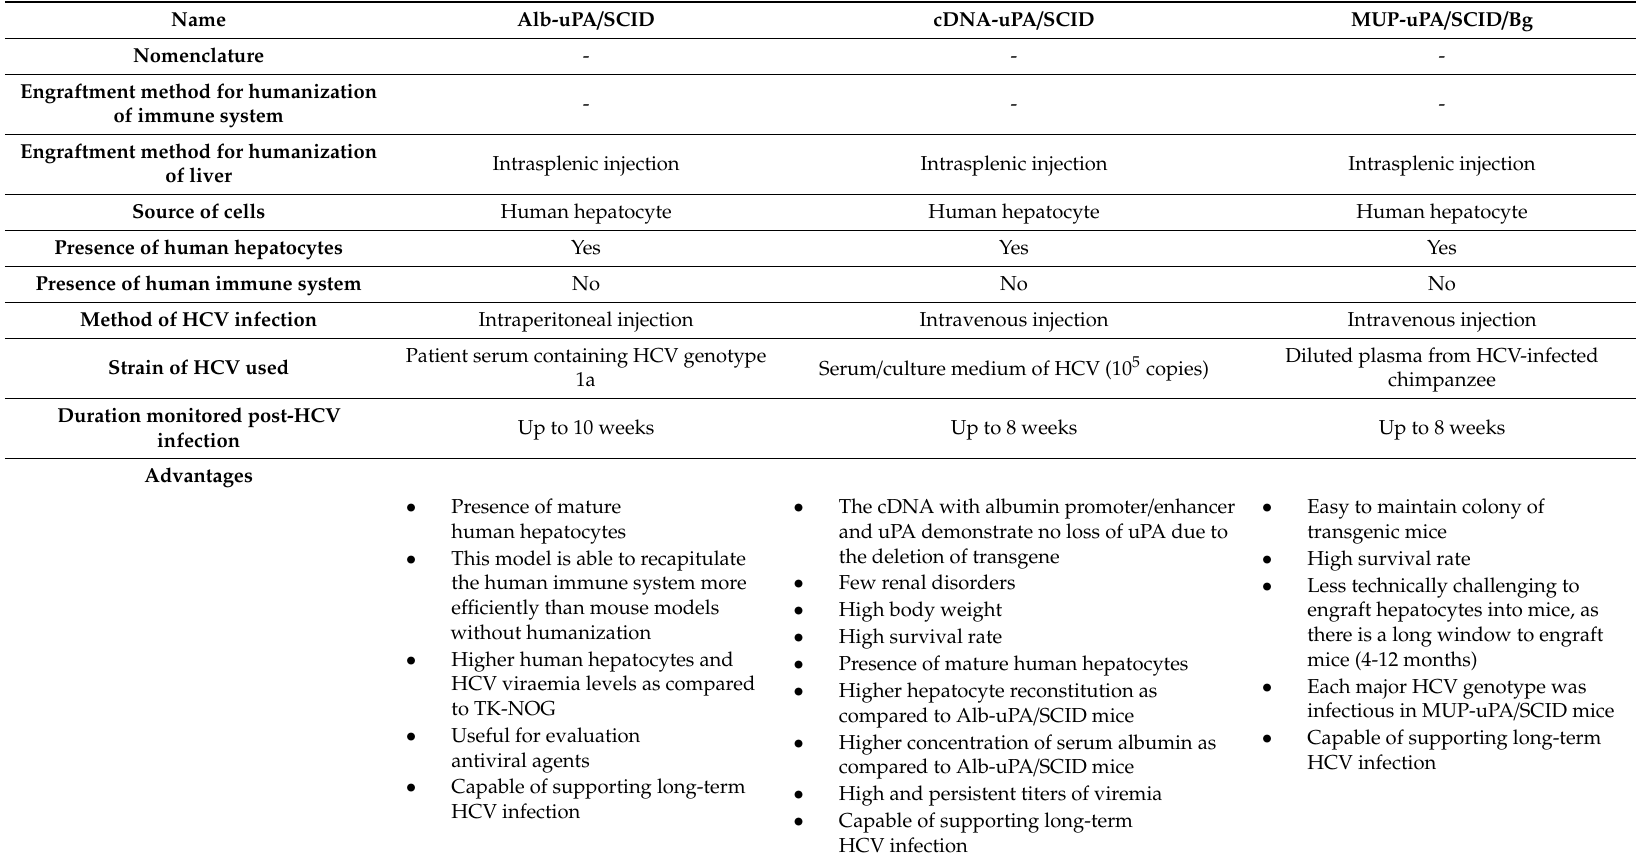
Table 1. Chimeric human liver mouse models (Part